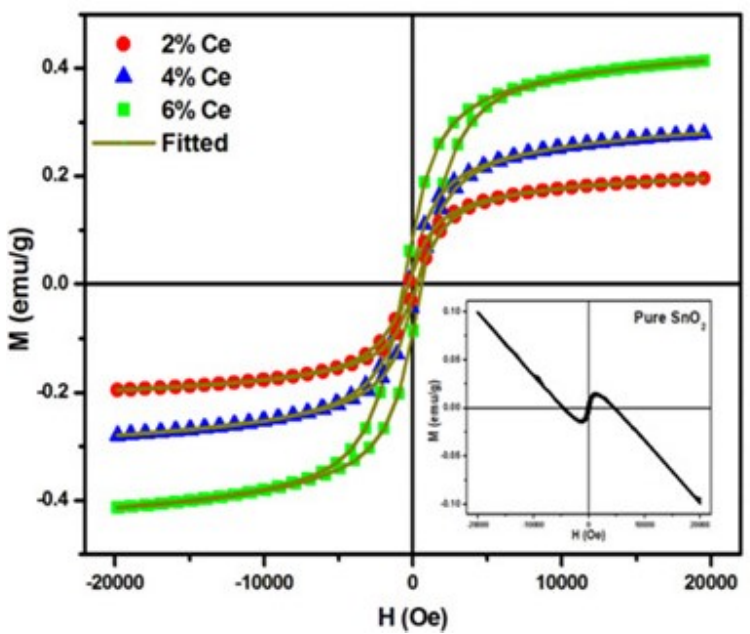
Figure 9. M ‐ H hysteresis loop of Ce doped SnO 2 NPs and inset shows M ‐ H curve of undoped SnO 2 NPs (The Figure was reproduced with copyright permission Springer from reference [64]).